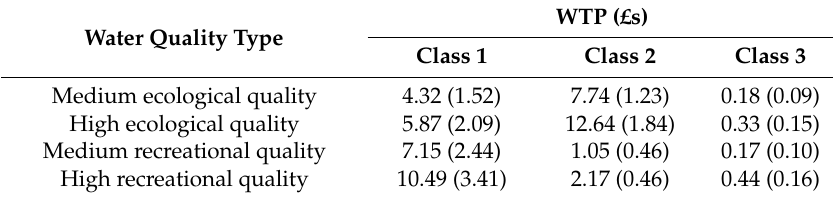
Table 5. Willingness to pay (WTP) derived from the latent class (LC) model for each water quality